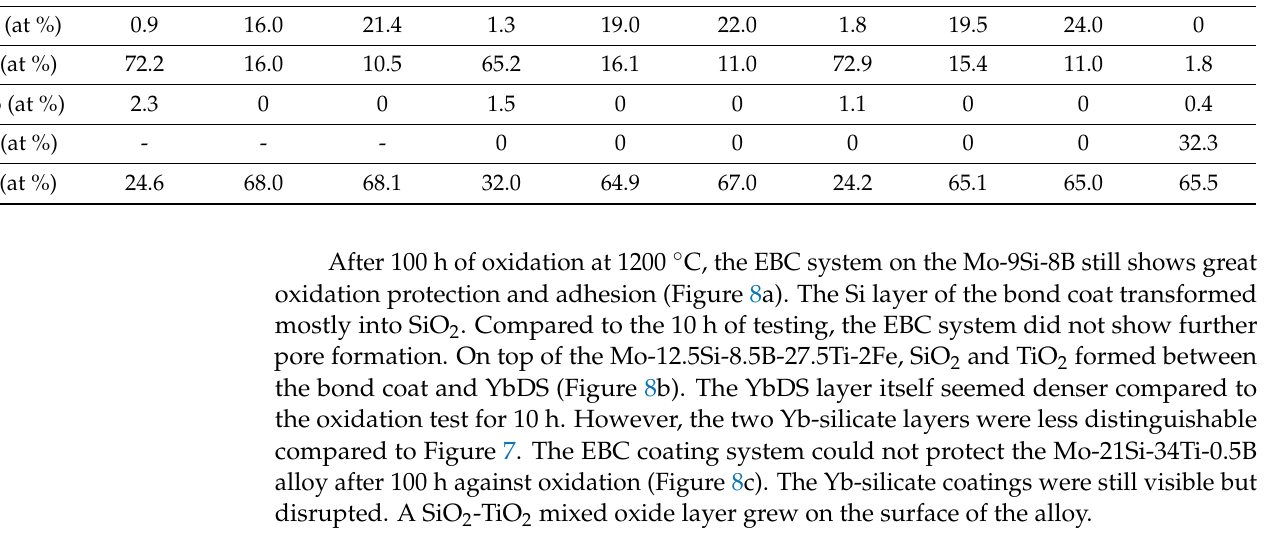
Figure 7. Secondary electron SEM micrographs of the dual-layer bond coat and the YbDS and YbMS top layer on ( a ) Mo-9Si-8B alloy, ( b ) Mo-12.5Si-8.5B-27.5Ti-2Fe alloy, ( c ) Mo-21Si-34Ti-0.5B alloy after 10 h of oxidation test at 1200 °C in air with a position marked by red dots for different EDS spot analyses represented in Table 2.